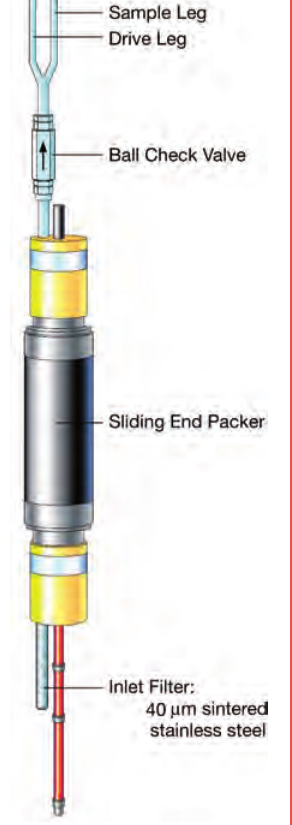
Figure 1. Schematic layout of the U-tube sampling system as deployed at the Frio Site, Dayton,